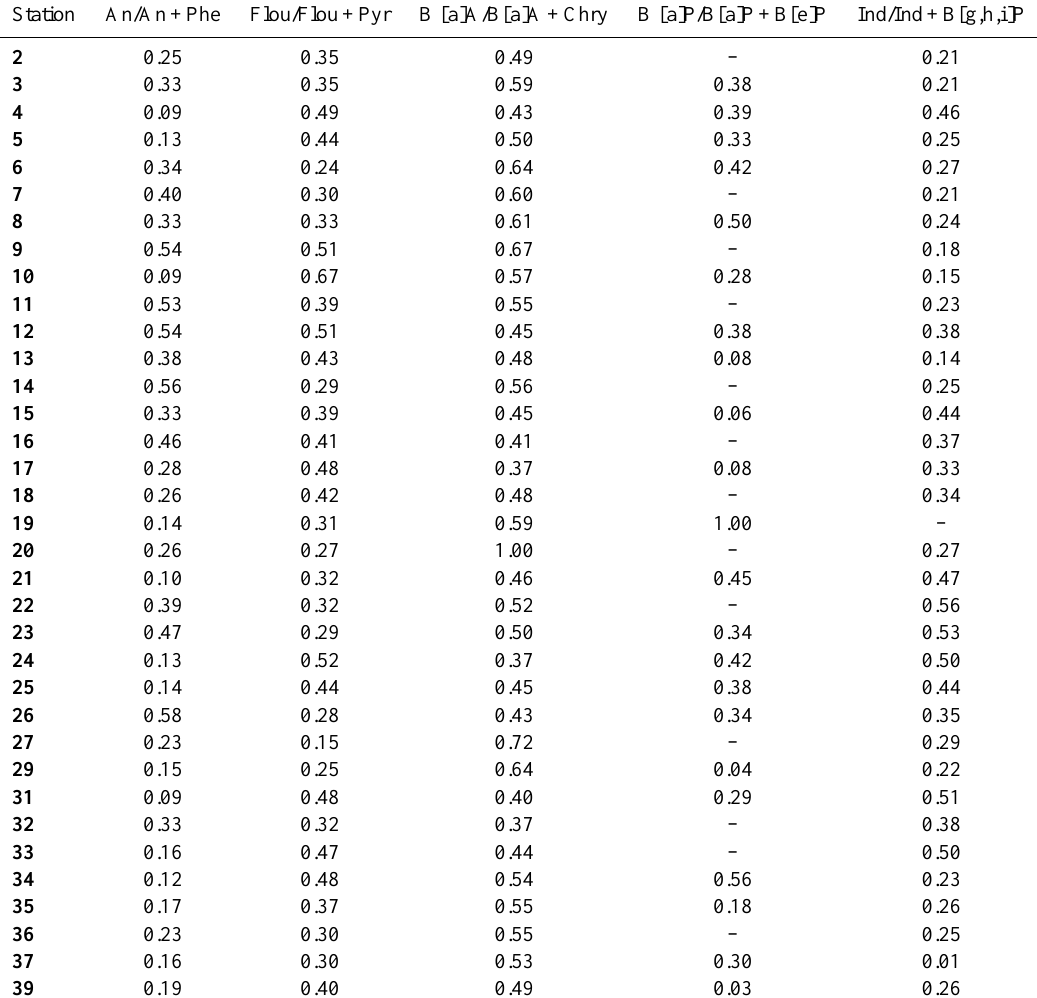
Table A5. Five of Diagnostic ratios of Khao Lak